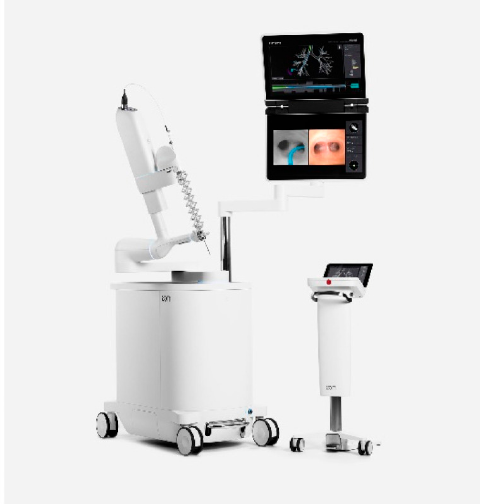
Figure 1. Ion™ Endoluminal System by Intuitive Surgical.